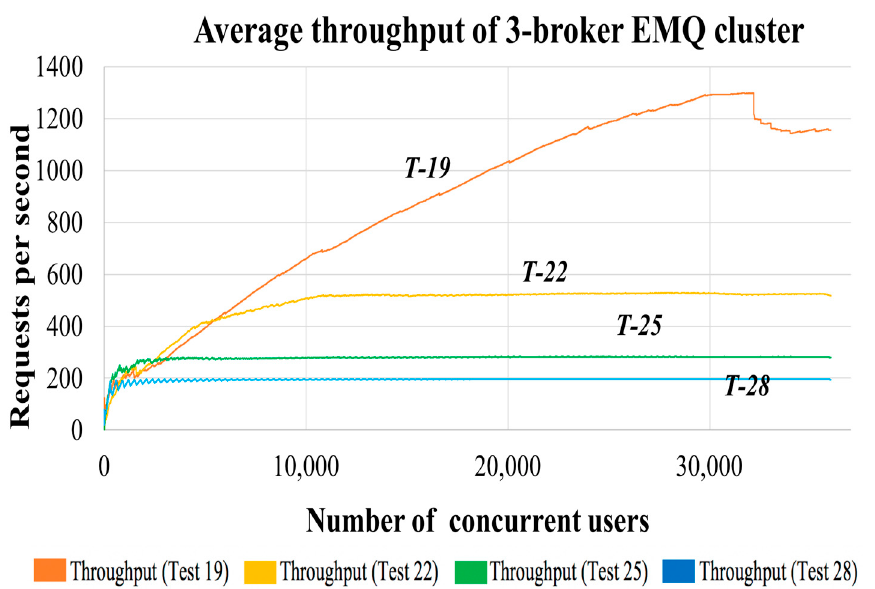
Figure 17. Average throughput of a 3-broker EMQ cluster subjected to a workload of 36,000 requests for 1 s (Test 19), 60 s (Test 22), 120 s (Test 25), and 180 s (Test 28).